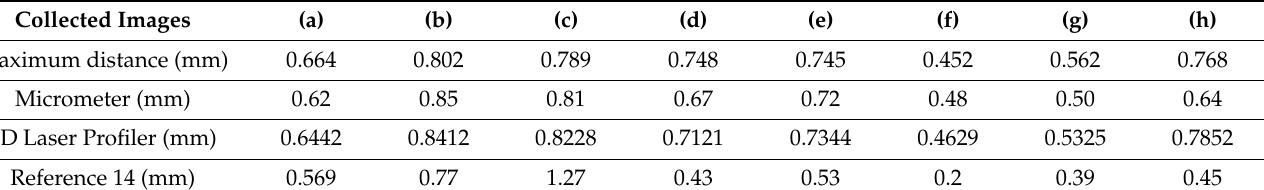
Figure 23. ROI image of the guide wire profile: ( a – d ) is the ROI of the 2.4 mm wire profile; ( e – h ) is the ROI of the 2.6 mm wire profile.